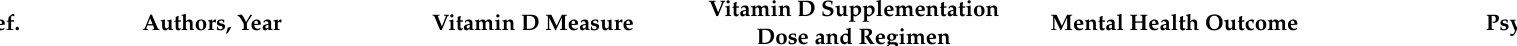
Table 4. The characteristics of the exposure and outcome studied within the studies included in the systematic review.